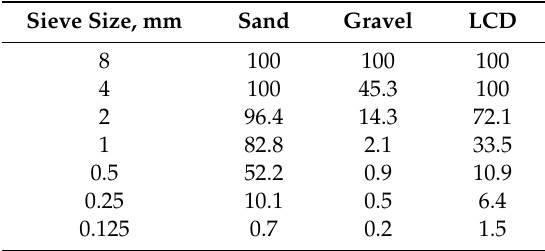
Table 5. Sieve analysis of the aggregate as well as liquid crystal display (LCD) waste, %. Sieve Size,